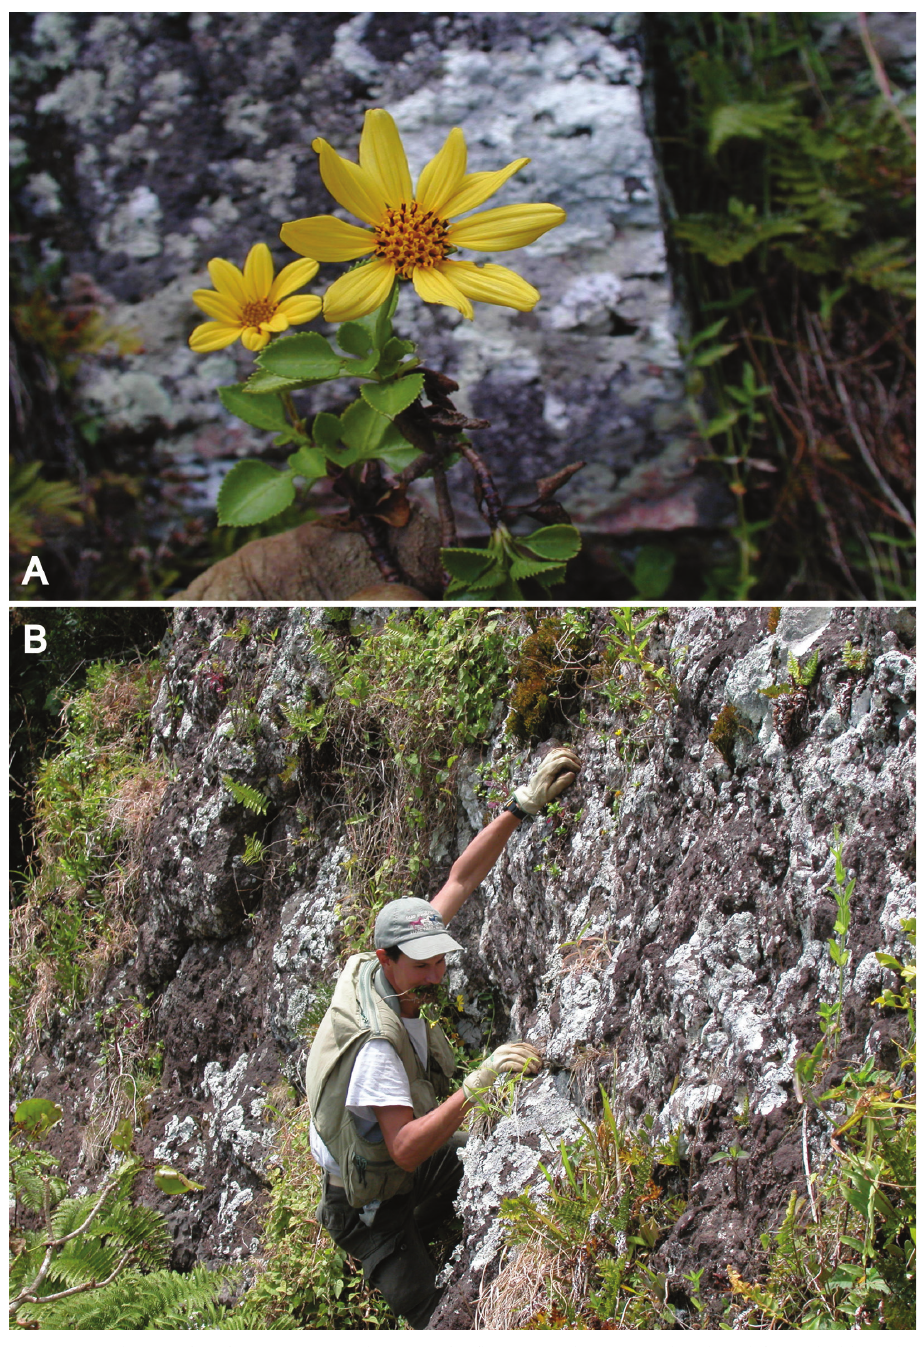
Figure 1. Photos of Bidens meyeri : A Close up of a flowering plant, note the gloved finger holding the plant B J-Y Meyer climbing with Bidens in his teeth, note yellow flowering plant on the cliff face just above his left hand. [Photo credits: A by J-Y Meyer; B by R Englund; both taken 16 Dec